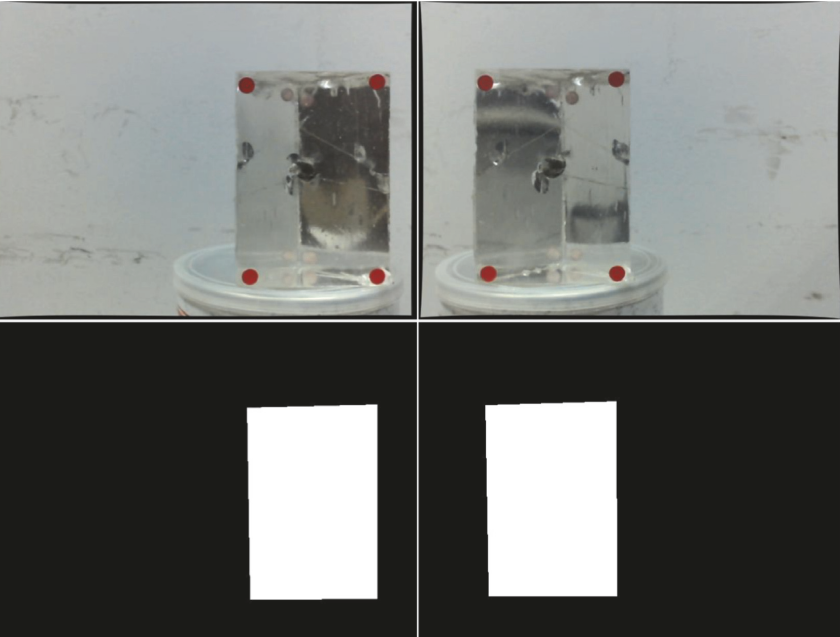
Figure 12: The binary image of the valid region for the image corresponding operation (the white area of the bottom